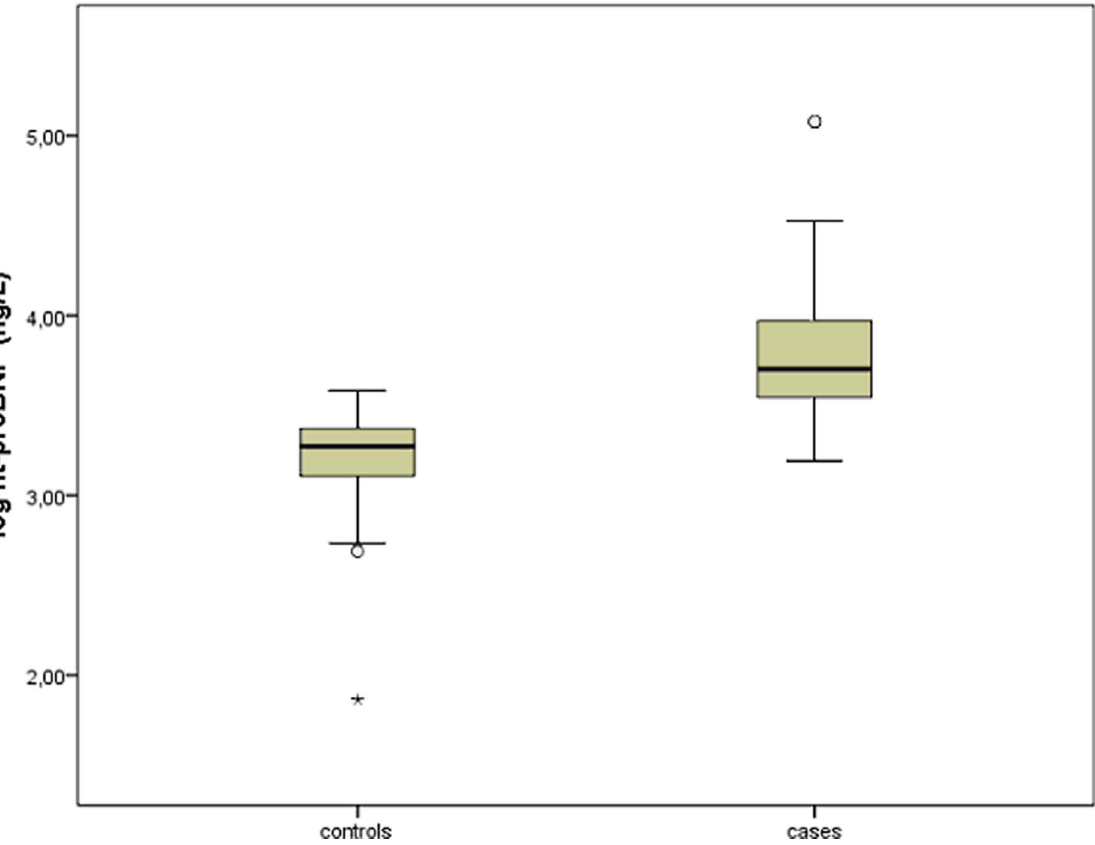
Figure 2. Nt-proBNP concentration in fetuses with urinary tract malformations and controls [ 16 ] . Depicted values are log-transformed. * , u denotes outliers. Mann-Whitney-U test: p , 0.001.